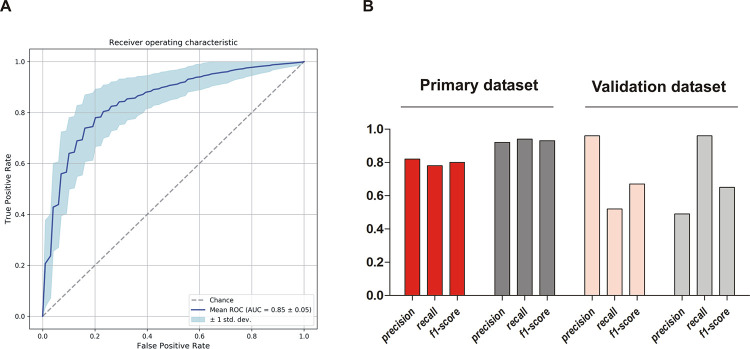
Performance parameters of k-mer-based prediction model.(A) Receiver operating characteristic curve (ROC-curve) of the final model including 96 k-mers associated with either infection or colonization. (B) Performance characteristics of the prediction model on the primary dataset and on the validation dataset from a previous study. Performance on infection isolates from this study (INF isolates) in red, performance on commensal isolates from this study (nCloNo isolates) in dark grey, performance on validation dataset in light red (infection isolates) and light grey (commensal isolates). Precision = (#True positive)/(#True positive + #False positive)(positive predictive value); recall = (#True positive)/(#True positive + #False negative)(sensitivity); f1-score = 2 * precision * recall / (precision + recall).